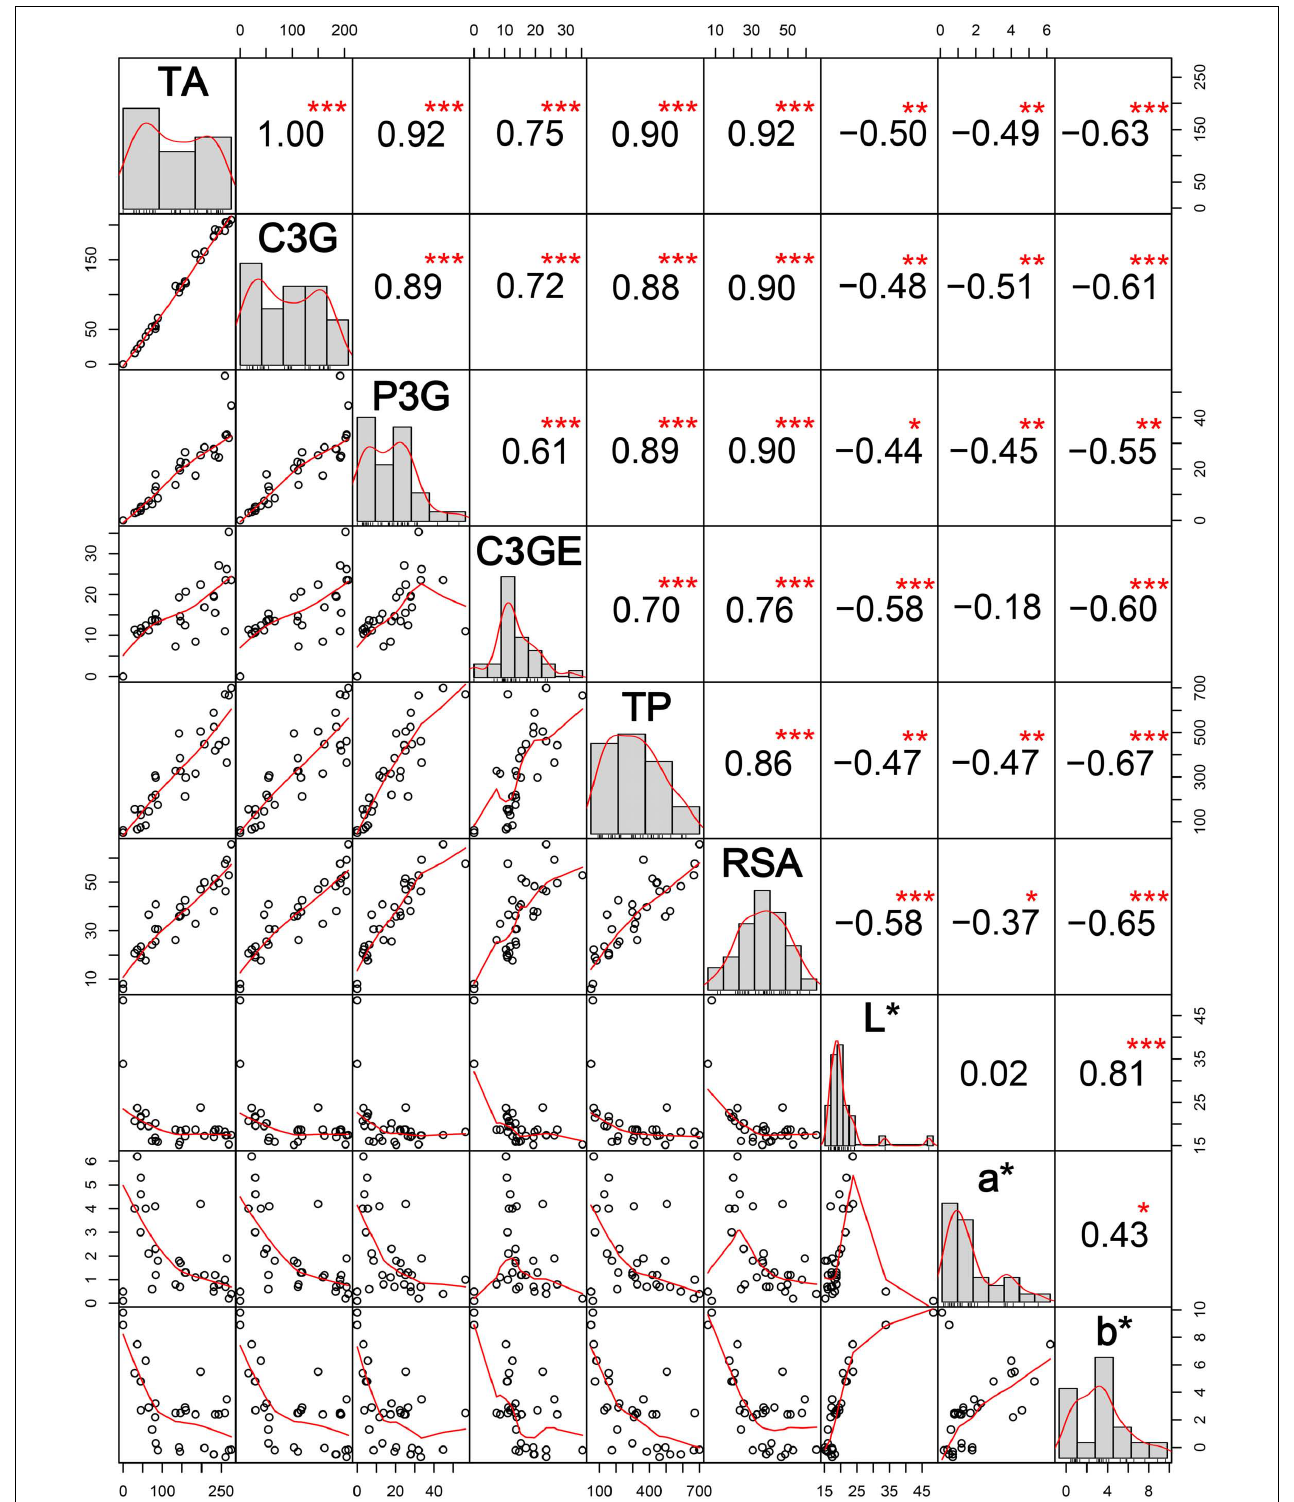
FIGURE 9 | Interrelations among anthocyanin content, nutraceutical properties, and CIELAB color scales among thirty black rice genotypes from Manipur. TA, total anthocyanin content in mg 100g - 1 DW; C3G, cyanidin-3-o-glucoside in mg 100g - 1 DW; P3G, peonidin-3-o-glucoside in mg 100g - 1 DW; C3GE, cyanidin-3-o-glucoside equivalent in mg 100g - 1 DW; TP, total phenolics in mg gallic acid equivalent (GAE) 100 g - 1 DW; RSA, radical scavenging activity in percentage; L*, a*, and b* are CIELAB color scales. *, **, *** Significant at probability levels of 0.05, 0.01 and 0.001, respectively.